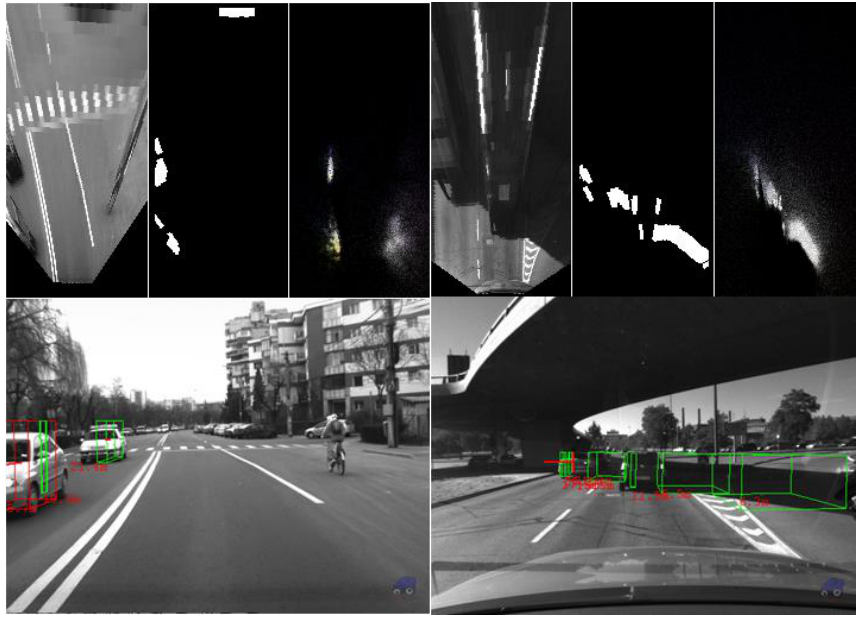
Figure 16. Failure cases: ( Left ) The bicyclist on the right side lane is not detected, due to its low contrast between the wheels and the road; and ( Right ) false positives due to strong shadows in very bright light. Figures 17–19 show the application running on mobile devices, in urban